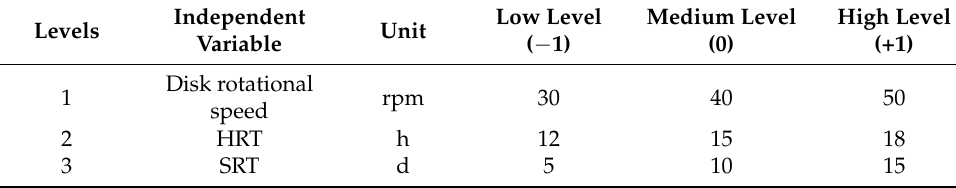
Table 3. Independent variables and levels used in Box–Behnken